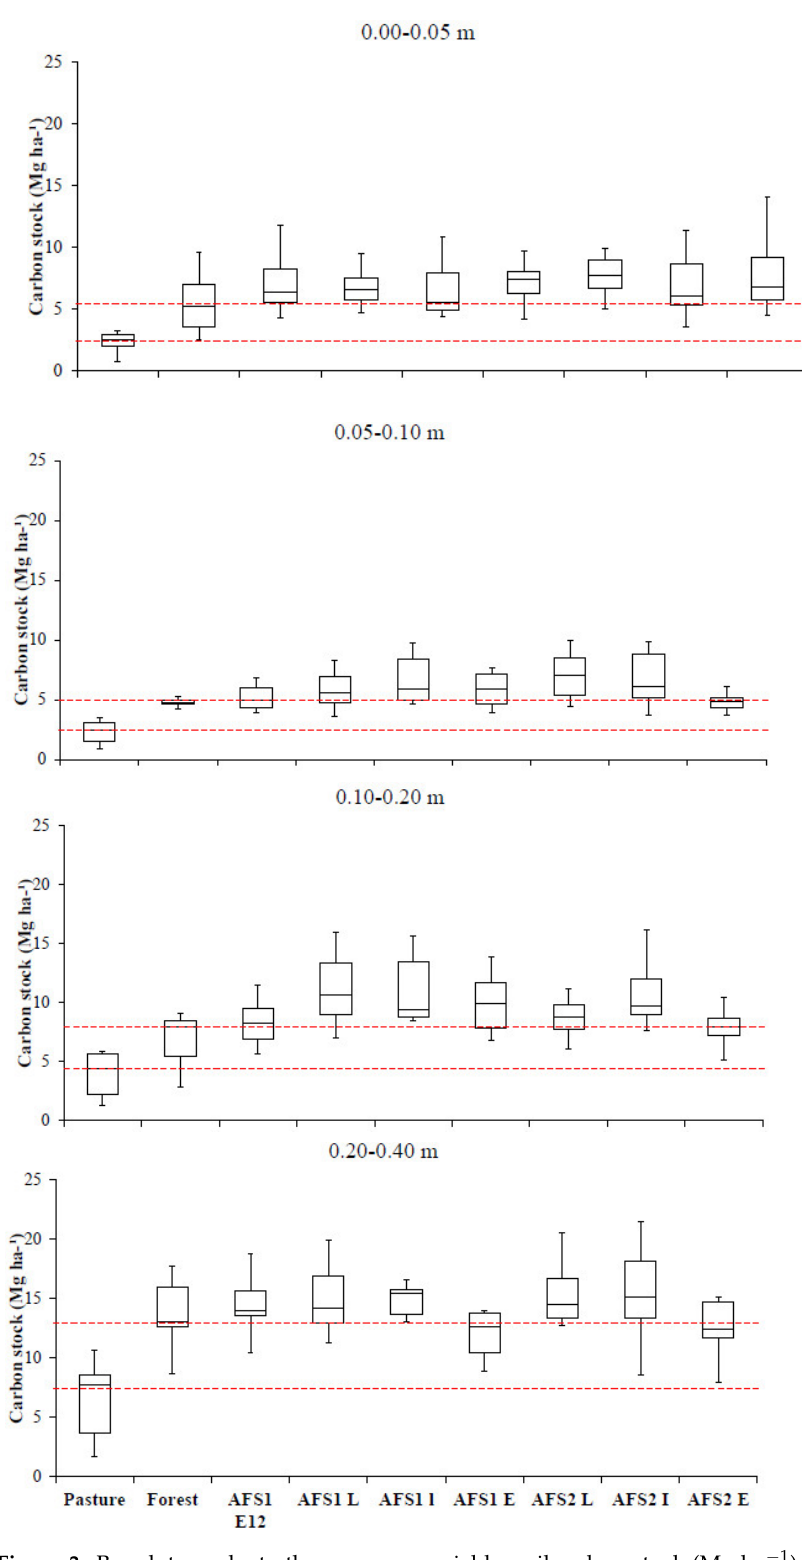
Figure 3. Boxplot graphs to the response variable, soil carbon stock (Mg ha − 1 ), in different land use systems. AFS1—agroforestry system developed for livestock, AFS2—agroforestry system developed for fruit culture, Pasture—pasture system, Forest—forest fragment in natural regeneration, L—planting windrows, l—tracks of windrow influence, E—inter-rows, and E12—inter-row of 12 m developed for animal